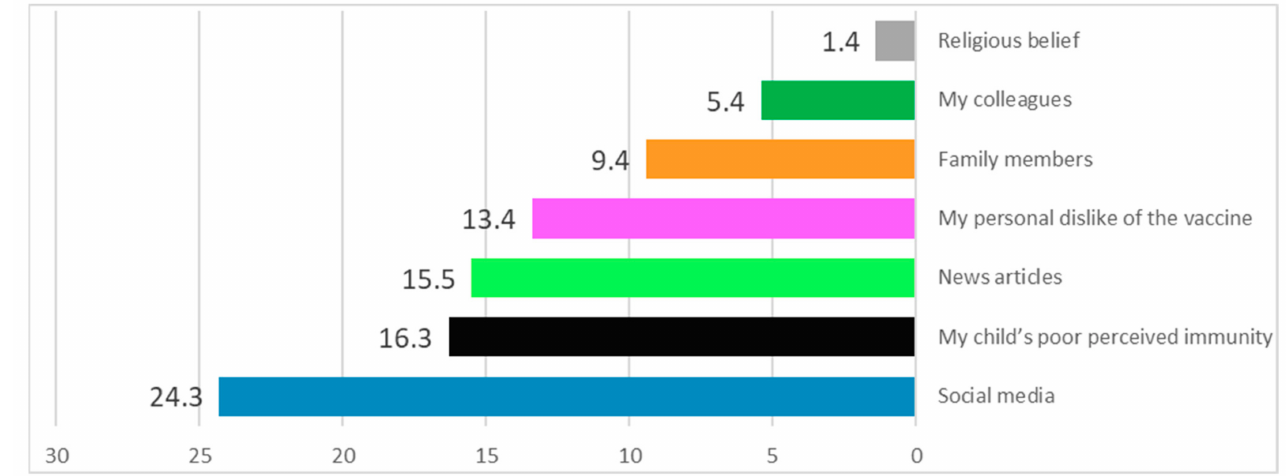
Figure 2. Factors influencing the parents’ decision on vaccine hesitancy for their